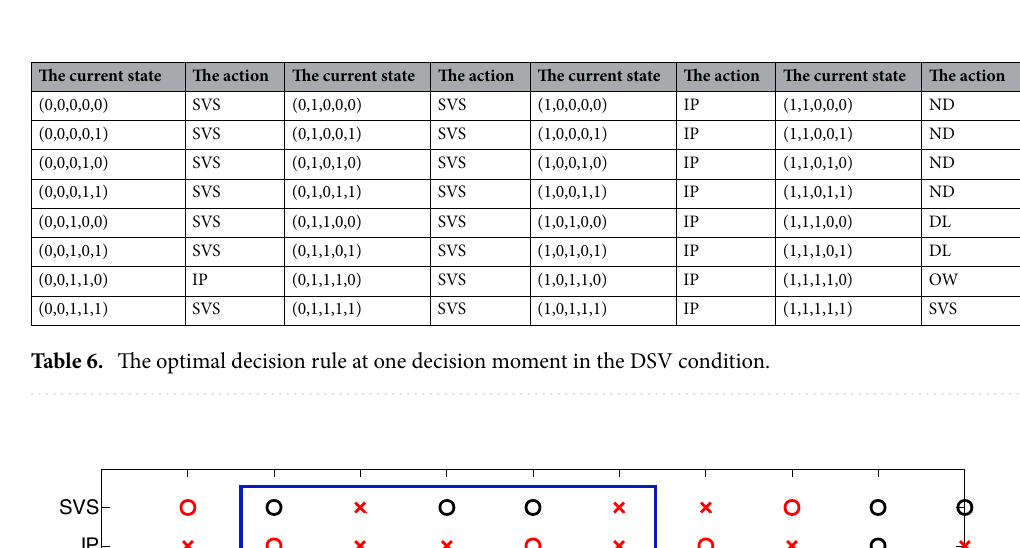
Table 5. The reward for one decision point in the DSV condition.